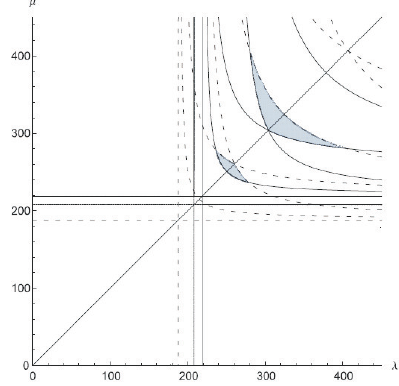
,δ ) Figure 9. Only two “good” regions k D 2 ( k, 1 ,δ ) and D 3 ( k, 1 ,δ ) are nonempty k k if k = 1 . 08 and δ = 13 .